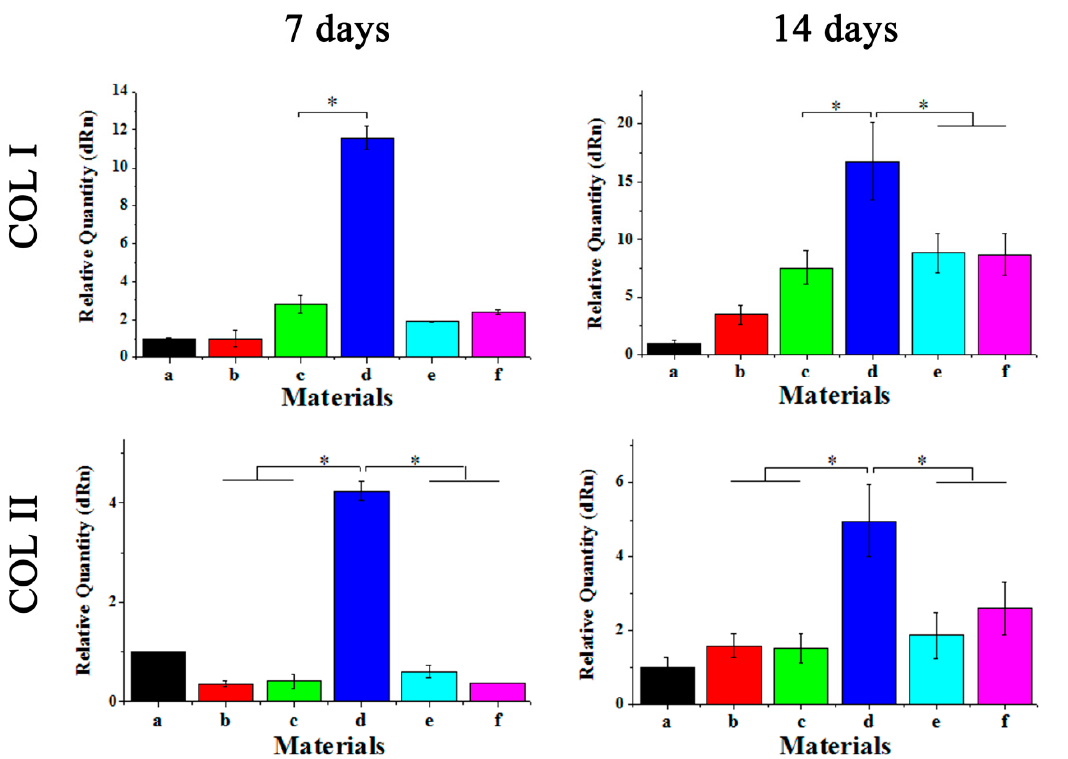
Figure 14. Gene expression of COL I and COL II in MC3T3-E1 cells cultured for 7 days and 14 days on different substrates: (a) glass, (b) PLGA, (c) GdPO 4 · H 2 O/PLGA, (d) GdPO 4 ·H 2 O@SiO 2 /PLGA (e) on different substrates: (a) glass, (b) PLGA, (c) GdPO 4 · H 2 O/PLGA, (d) GdPO 4 · H 2 O@SiO 2 /PLGA GdPO 4 ‧ H 2 O@SiO 2 –APS/PLGA and (f) PBLG-g-GdPO 4 ·H 2 O/PLGA. * p < 0.05. (e) GdPO 4 · H 2 O@SiO 2 –APS/PLGA and (f) PBLG-g-GdPO 4 · H 2 O/PLGA. * p <